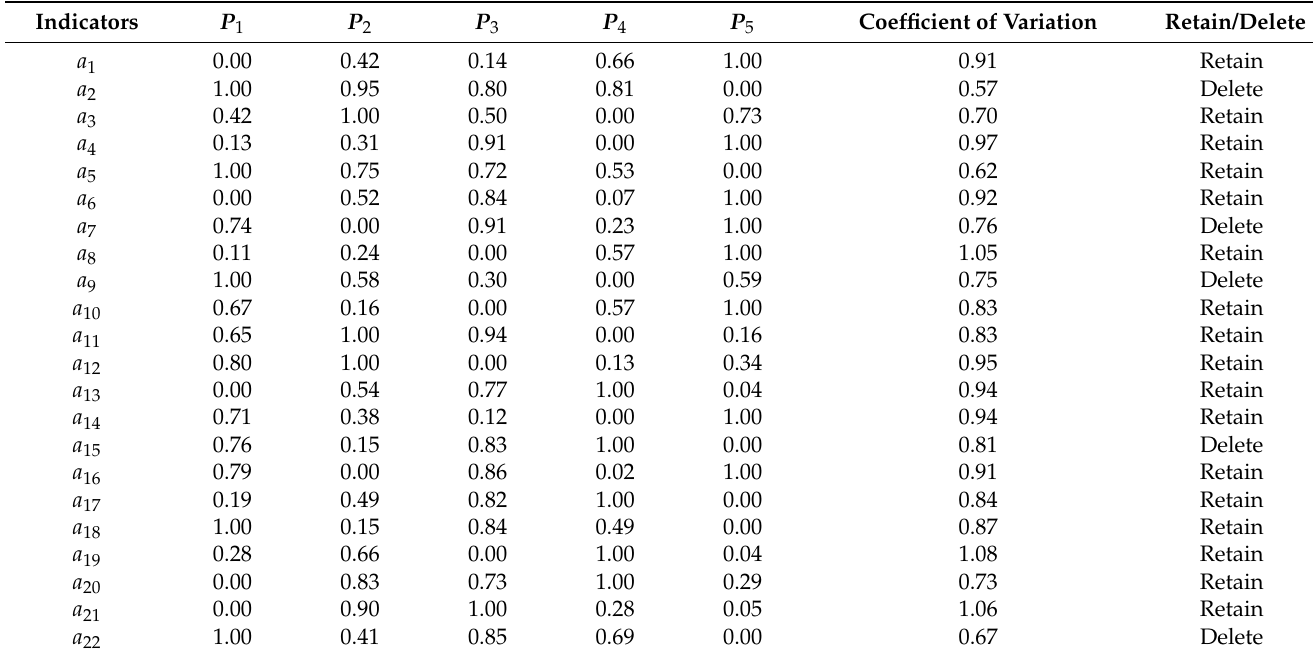
Table 1. Screening of evaluation indicators.